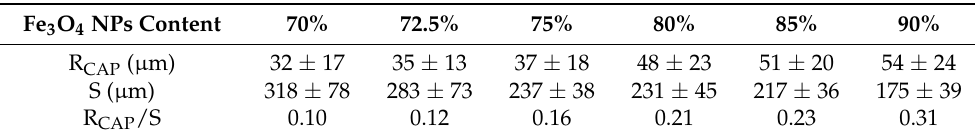
Table 2. Relationships between the geometrical parameters of the mushroom-like pillars and Fe 3 O 4 NPs